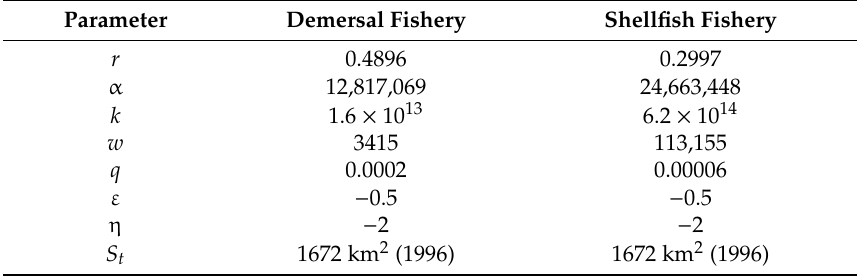
Table 1. Key parameters for mangrove-dependent fisheries, Thailand.